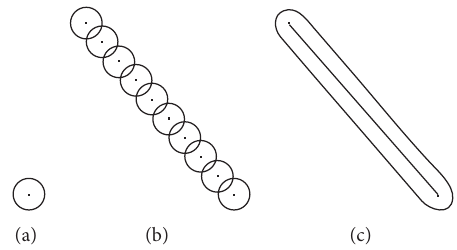
Figure 3: Distributed point source method idea illustrated. (a) Single source, (b) multiple sources, and (c) infinite sources.